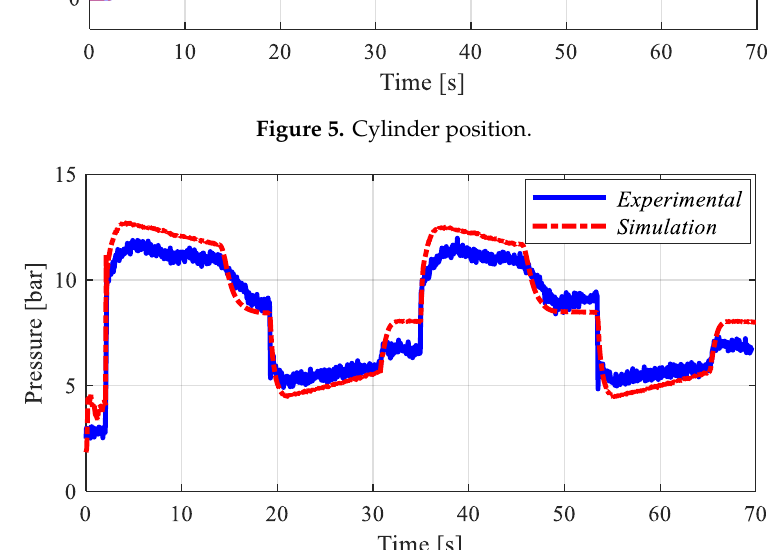
Figure 6. Piston head side chamber pressure.